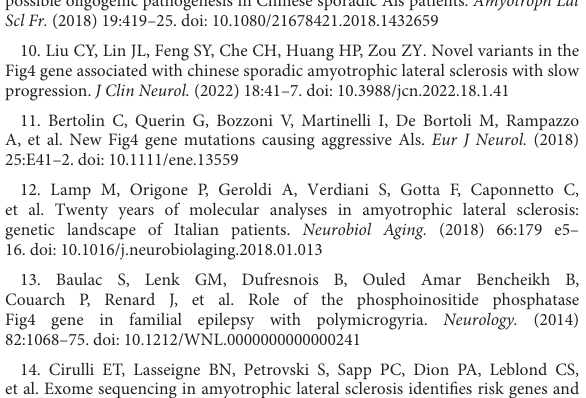
Fig4 gene with frontotemporal dementia and slowly progressing motoneuron disease: a case report depicting common challenges in clinical and genetic diagnostics of rare neuropsychiatric and neurologic disorders. Front Neurosci. (2020) 14:559670. doi: 10.3389/fnins.2020.559670